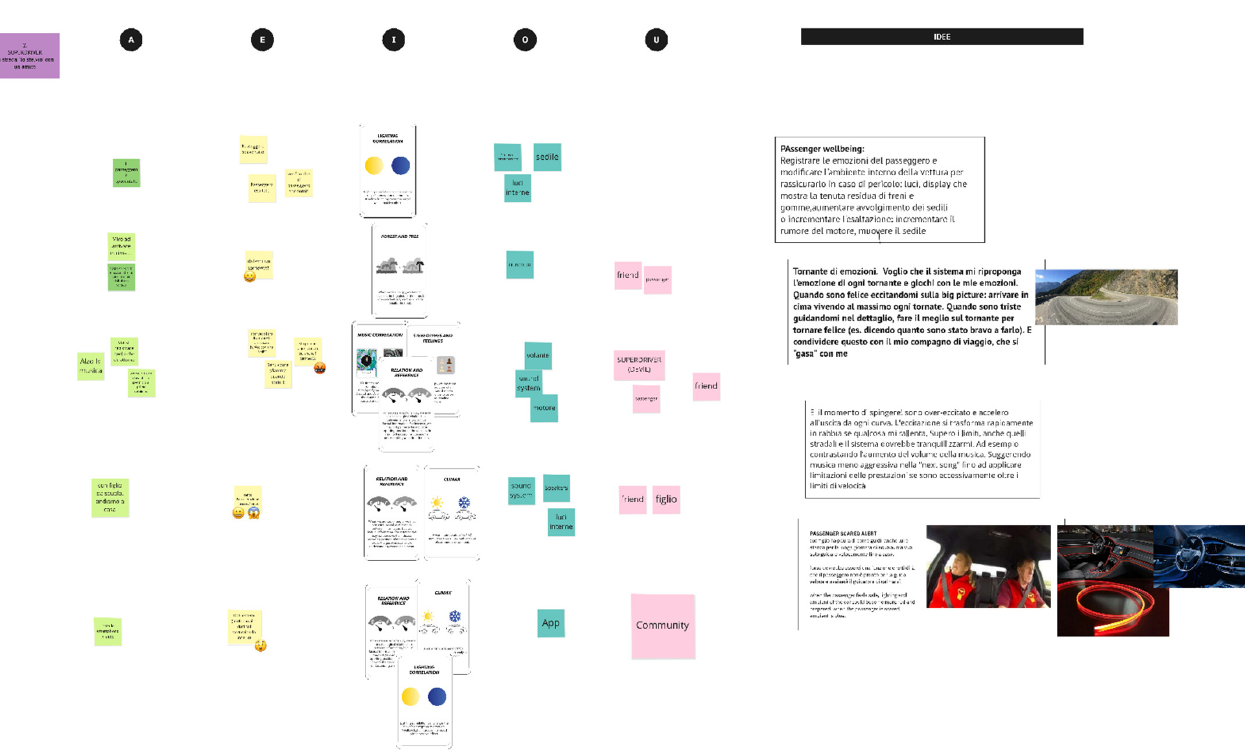
Figure 5. The conclusion of the ideation phase for the Superdriver